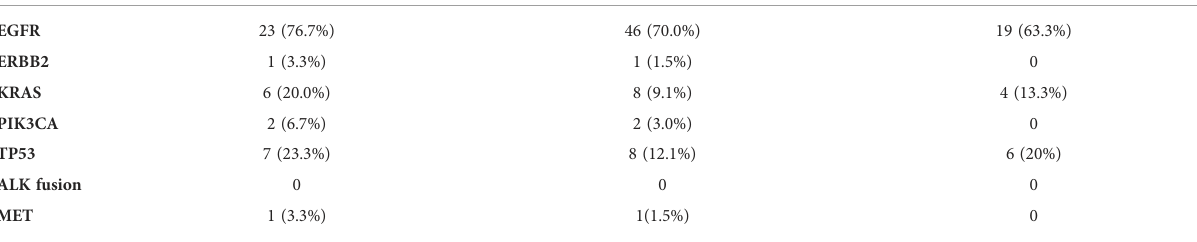
TABLE 2 The clinical and driver mutation genes characteristics of 30 patients. Driver